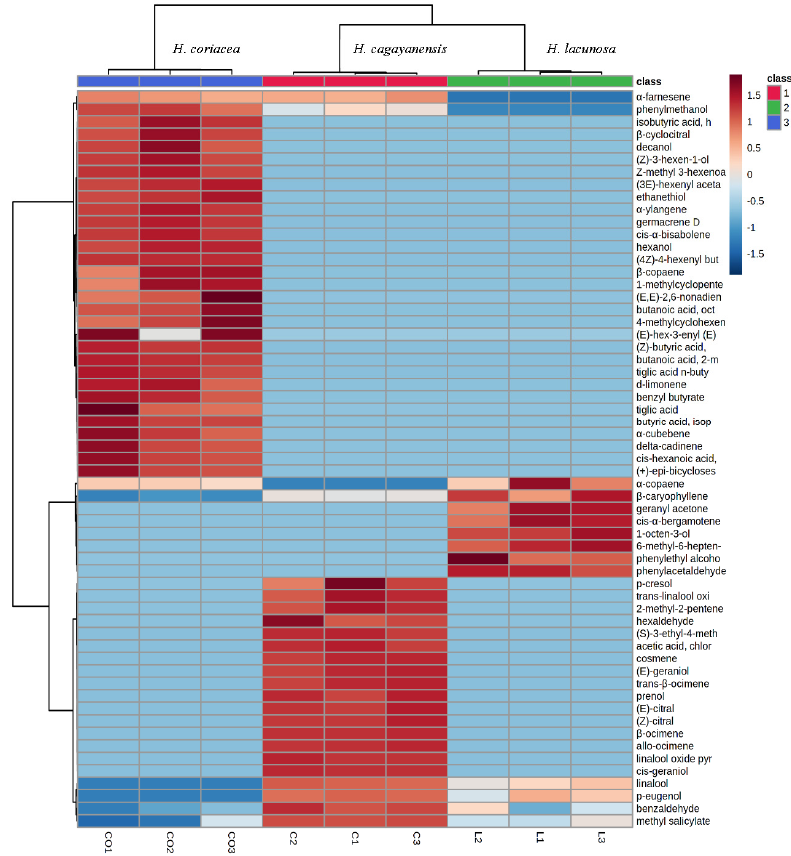
Figure 2. Heat map represents metabolites of different abundance between the flowers of Hoya species. Red hues indicate high metabolite content and blue hues indicate low metabolite content.